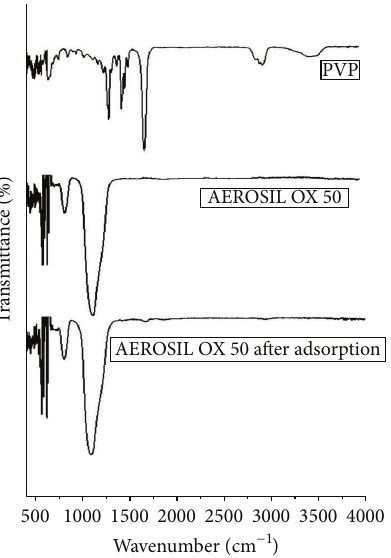
Figure 13: FTIR spectra of silica, PVP, and silica after adsorption of